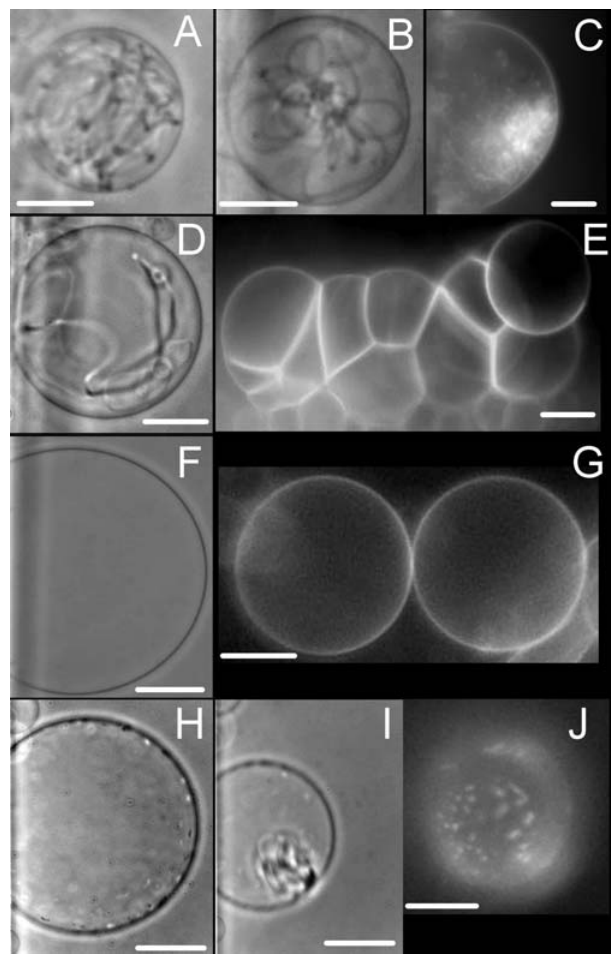
Figure 2. Penetratin effects on GUV in liquid disordered (non- raft) and liquid ordered (raft-like) domains. GUV obtained by electroformation were incubated with Penetratin or fluorescent Penetratin as described in the methods section. Tubulation was only observed in membranes in the liquid disordered state. DOPC (A), egg yolk PC (B,C) and PC/PG (9/1) (D) GUV. Peptide induced vesicles adhesion was observed in all GUV (only shown for PC/PG) (E). Peptides showed no tubulation effect in membranes in the liquid ordered state (‘‘raft-like’’ SM/Chol (1/1)) (F,G). In SM/Chol membranes supplemented with 10% PG, Penetratin clusterizes at the GUV surface (H,J) and then provokes a grape-like vesiculation phenomenon (I) see also videos S1,S2,S3 in supplement. Dark field images were obtained with CF- Penetratin. Phase contrast images were obtained with cargo-free Penetratin. Bars 20 m m.